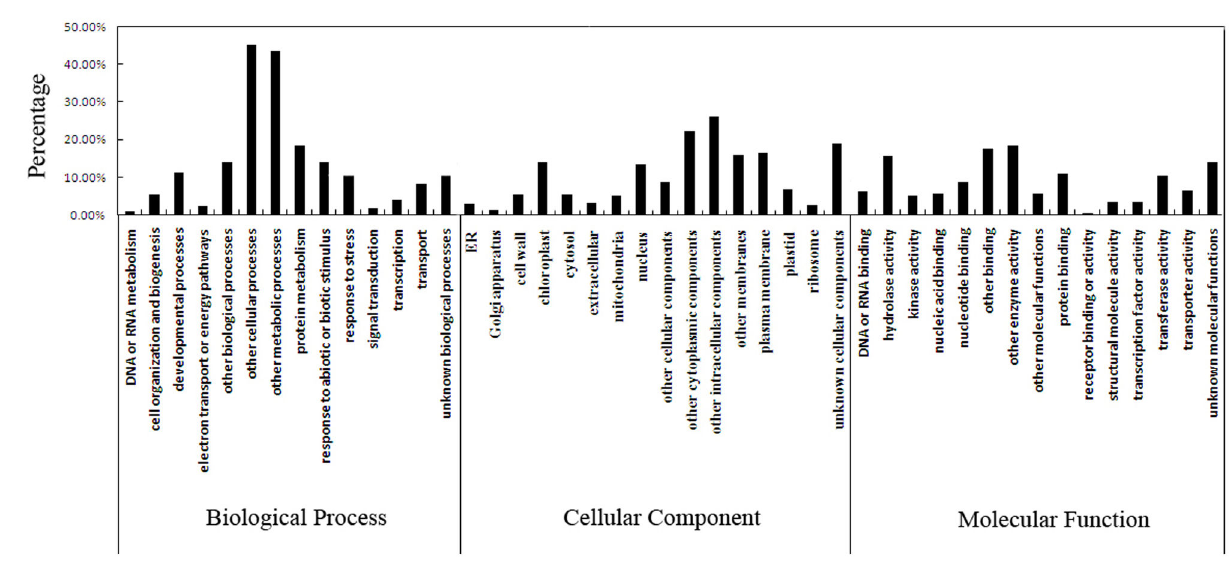
Figure 2. Representation of gene ontology assignments for plant homologous ESTs derived from SSH library. The GO slim Classification for Plants Developed at TAIR was used to functionally characterize the